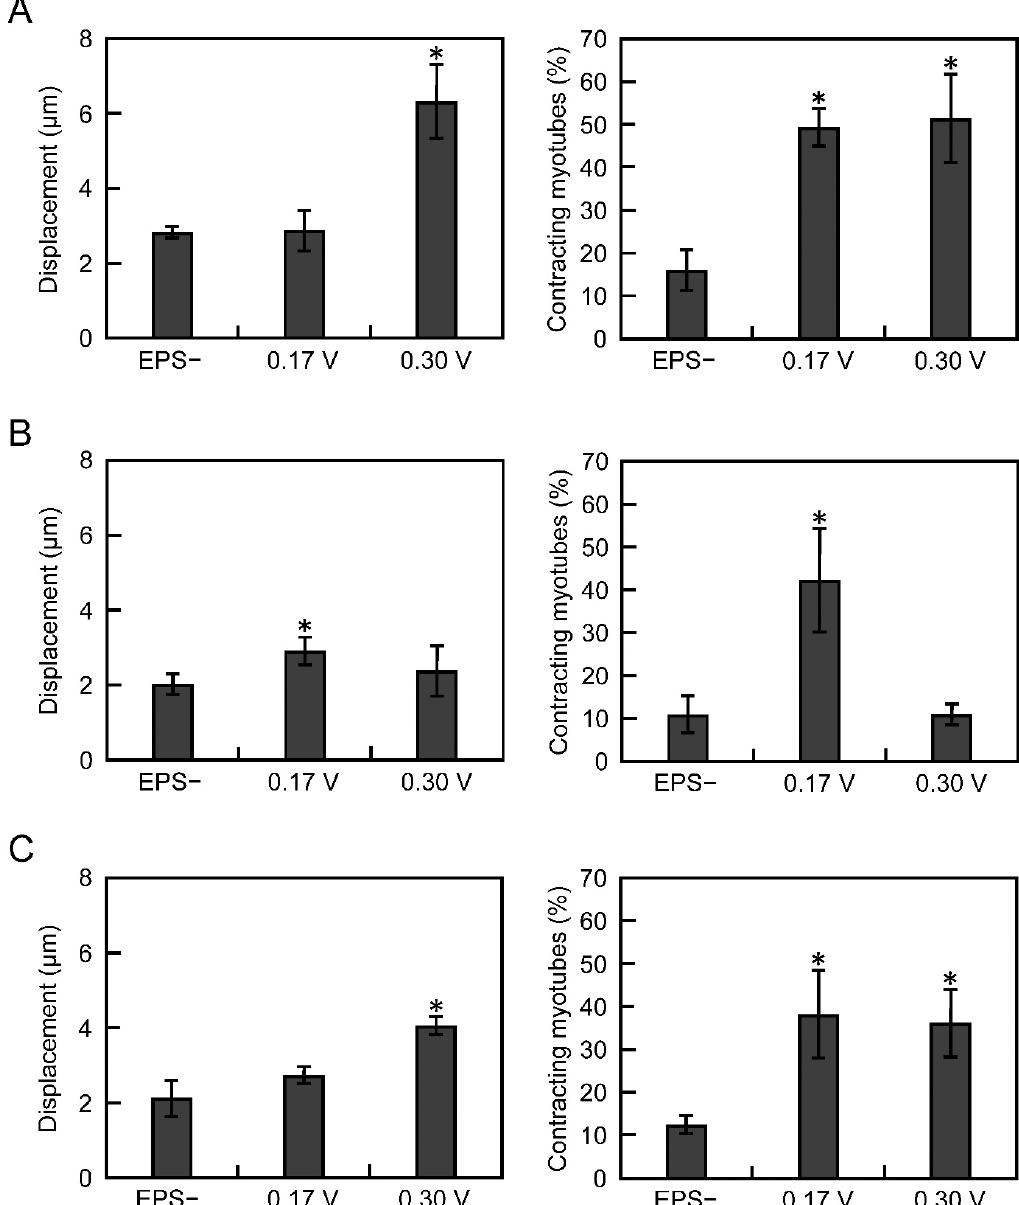
Figure 2. Contractile activity of human iPS cell-derived myotubes. Myotubes were cultured with or without electrical pulse stimulation (EPS). When EPS was applied to myotubes, two different voltages (0.17 and 0.30 V/mm) were used. Displacement (left) and the percentage of contracting myotubes (right) for N-iPS ( A ), D-iPS ( B ), and R-iPS ( C ) cell-derived myotubes were measured. Data are expressed as the mean ± SD ( n = 3). * p < 0.05 vs without EPS (EPS − ).